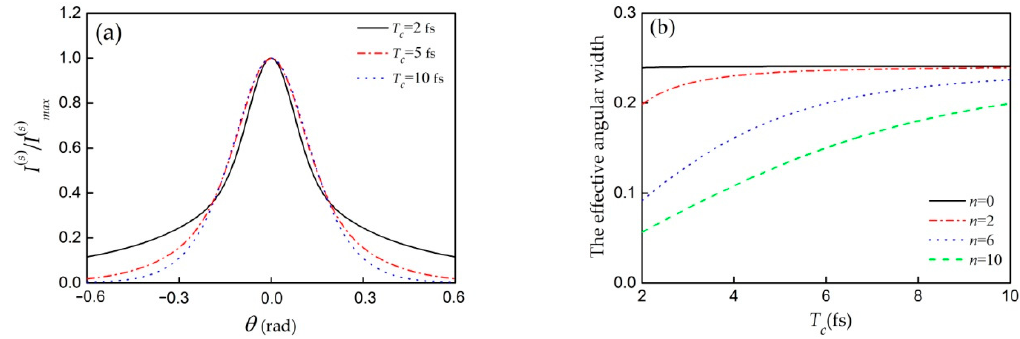
Figure 4. ( a ) Normalized intensity of scattered pulse against scattering angle θ ; ( b ) e ff ective angular width of scattered pulse against temporal-coherence length T c of initial